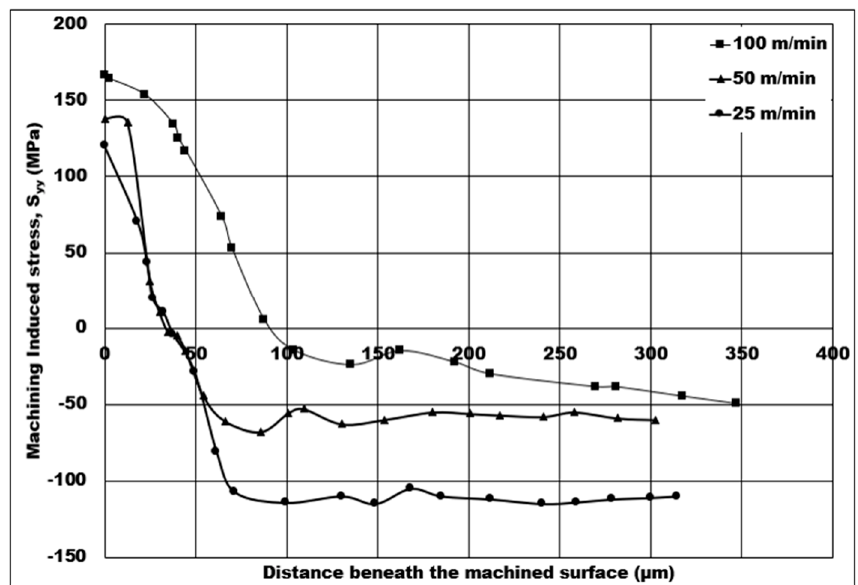
Figure 8. Numerical machining induced stress distribution under the influence of cutting speed (10% volume fraction, uncut chip thickness = 0.07 mm, dry cutting).